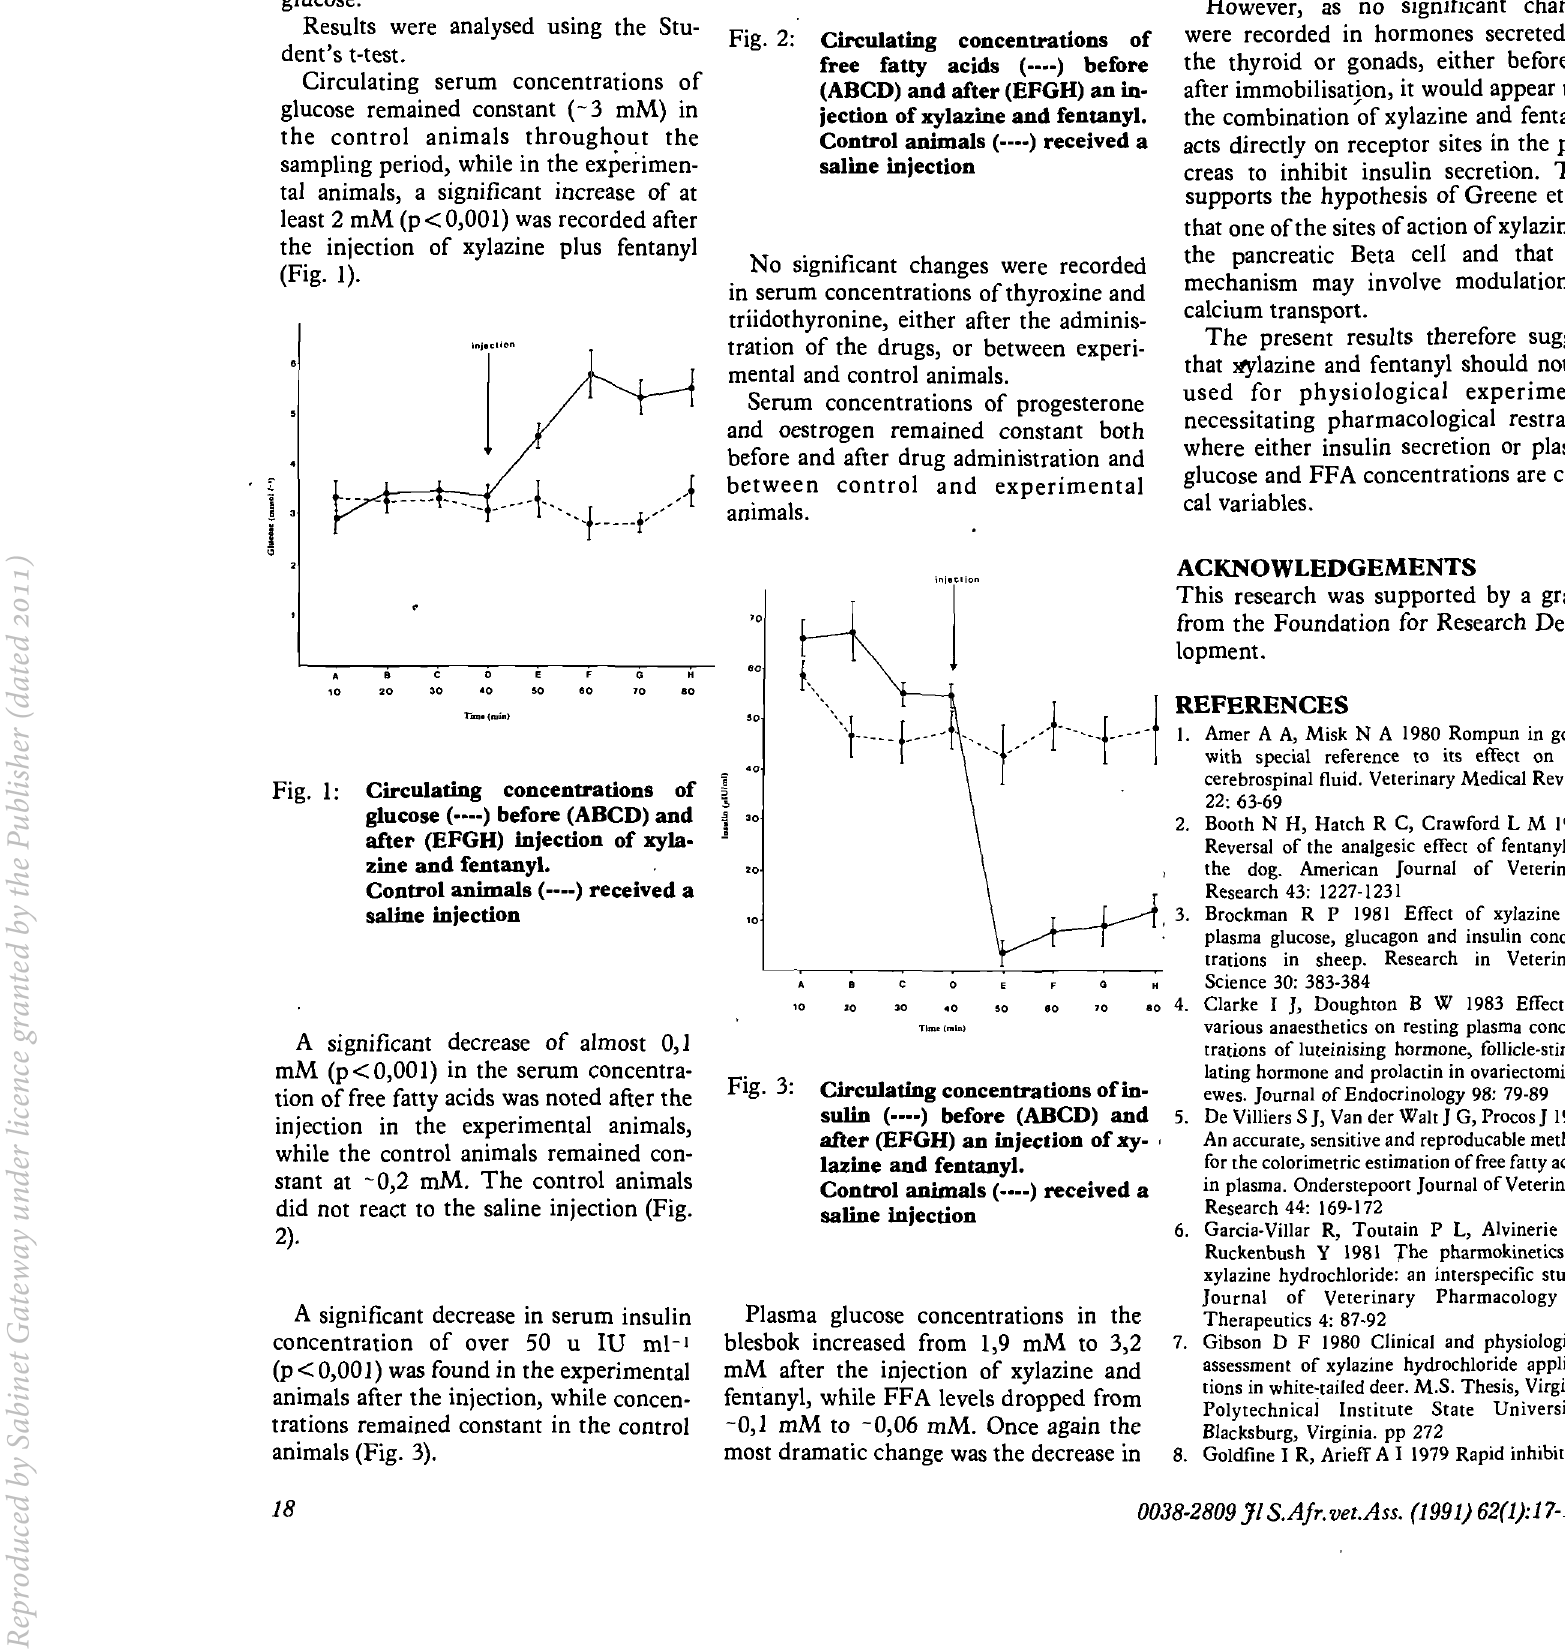
Fig. 2: Circulating concentrations of free fatty acids ( •••• ) before (ABCD) and after (EFGH) an in· jection of xylazine and fentanyl. Control animals (._ •• ) received a saline injection